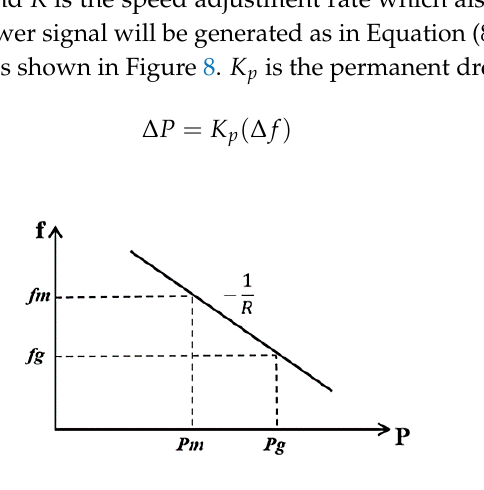
Figure 8. Droop control for VSWTs.